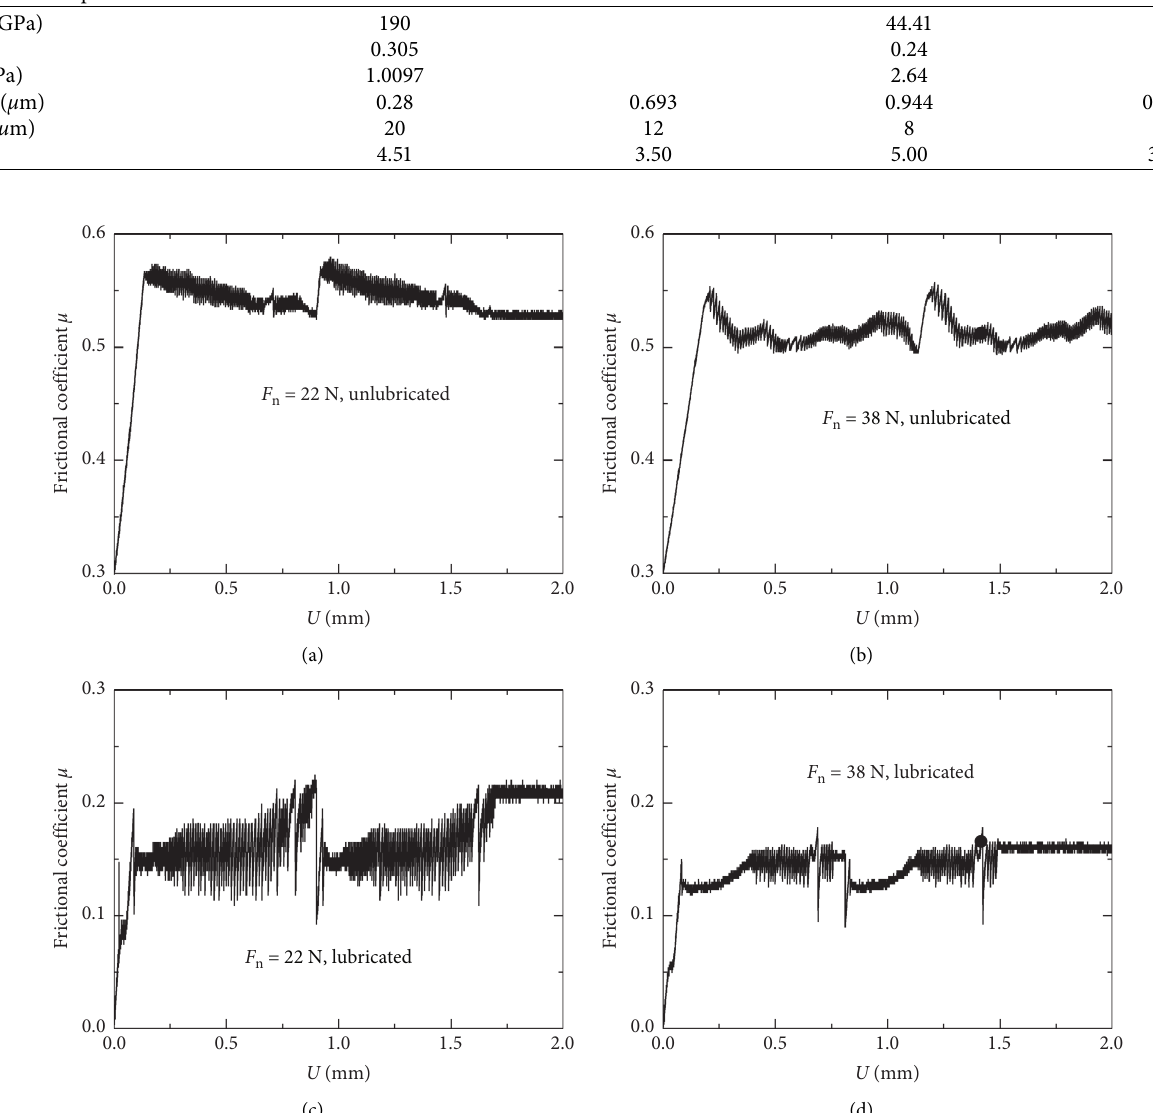
Figure 4: The friction coefficient during motion restart ( V � 22 . 78 μ m/ s and quiescent time equals